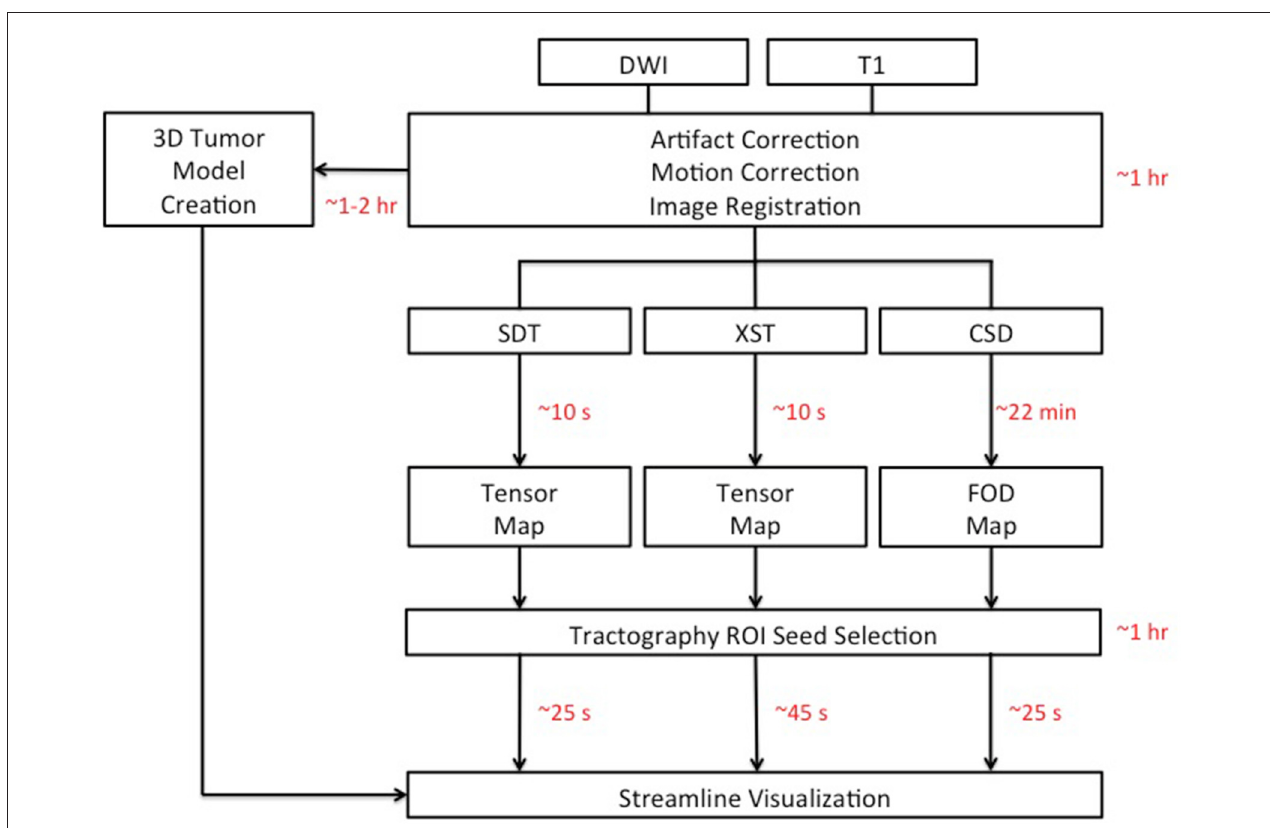
FIGURE 2 | Schematic detailing the analysis pipelines for all three tractography methods: Single Diffusion Tensor Tractography (SDT), EXtended Streamline tractography (XST), Streamline tractography on fiber orientation distributions (FODs) derived from constrained spherical deconvolution (CSD). Acquired diffusion-weighted imaging (DWI) scans were initially corrected for motion- and eddy current-related artifacts. This took ∼ 30minutes (min) to perform. Registration between T1 anatomical images and DWI images was complete within 1hour (hr) per patient. 3D models of tumors of the posterior cranial fossa took ∼ 1–2hr per patient to create. The creation of the tensor map was typically ∼ 10seconds (s) in duration, where the creation of the FOD map was typically ∼ 22min in duration. Tractography analysis for cranial nerves (CNs), not directly affected by the presence of a tumor, was complete within 10min for CN V and 20min for CN VII/VIII, on average. Tractography analysis for CNs directly affected by the presence of a tumor took longer with 30min on average for CN V generation in patients with tumors compressing CN V and 1–2hr in patients with tumors compressing CN VII/VIII. Once suitable seed ROIs had been created, SDT and CSD-based tractography took typically ∼ 25s on average for CN generation with XST typically taking ∼ 45s on average. DWI: Diffusion-Weighted